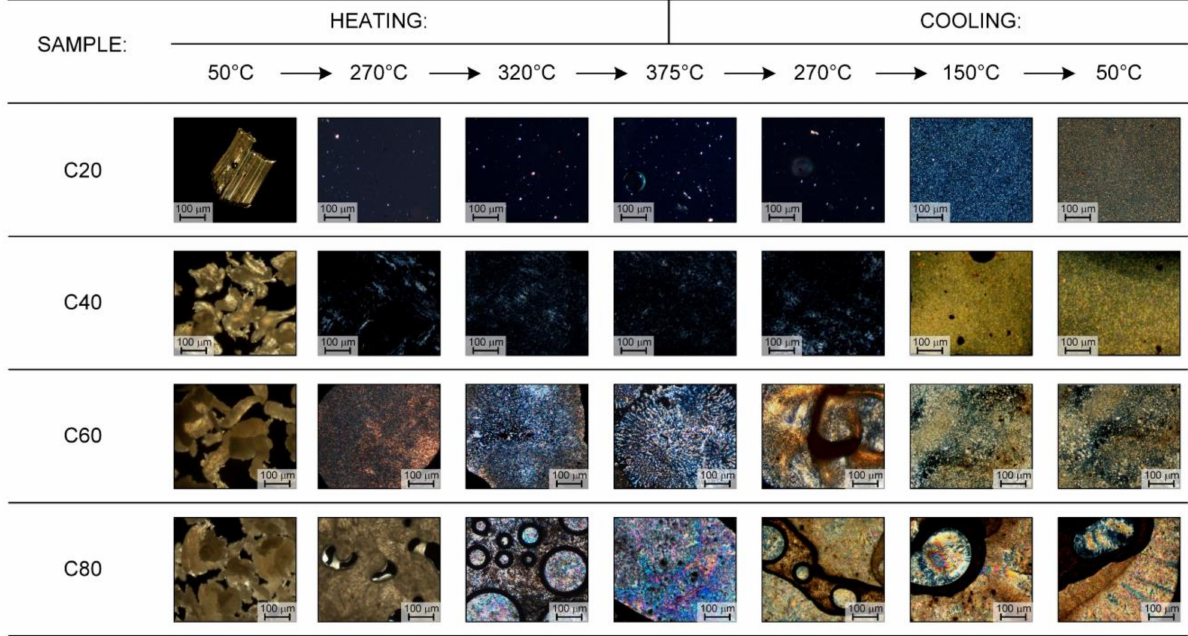
Figure 8. Micrographs of C20–C80 melts obtained in crossed polarizers during heating to 375 ◦ C and subsequent cooling to 50 ◦ C.